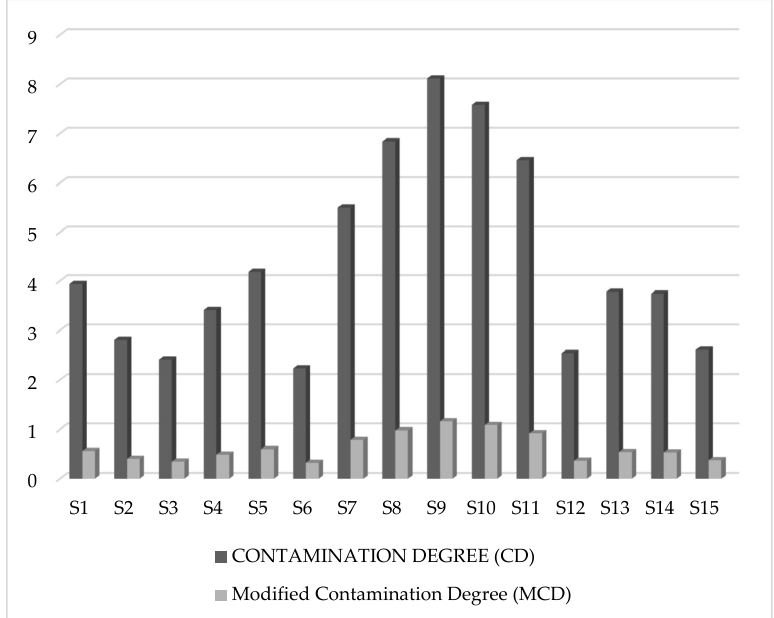
Figure 3. CD and MCD values of the heavy metals of the river sediment .